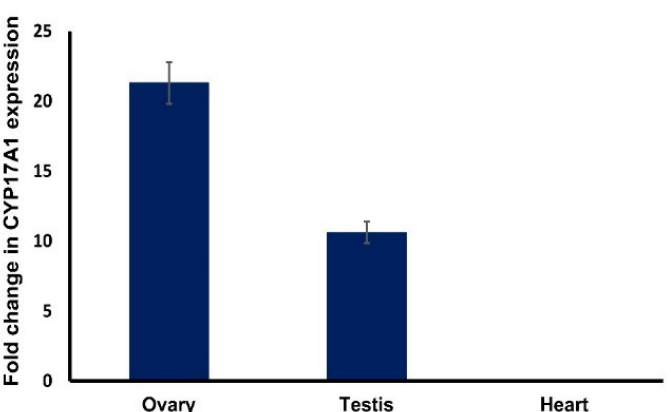
Figure 6. Normalized expression of mouse deer CYP17A1 with respect to β-actin in ovary, testis, and heart .